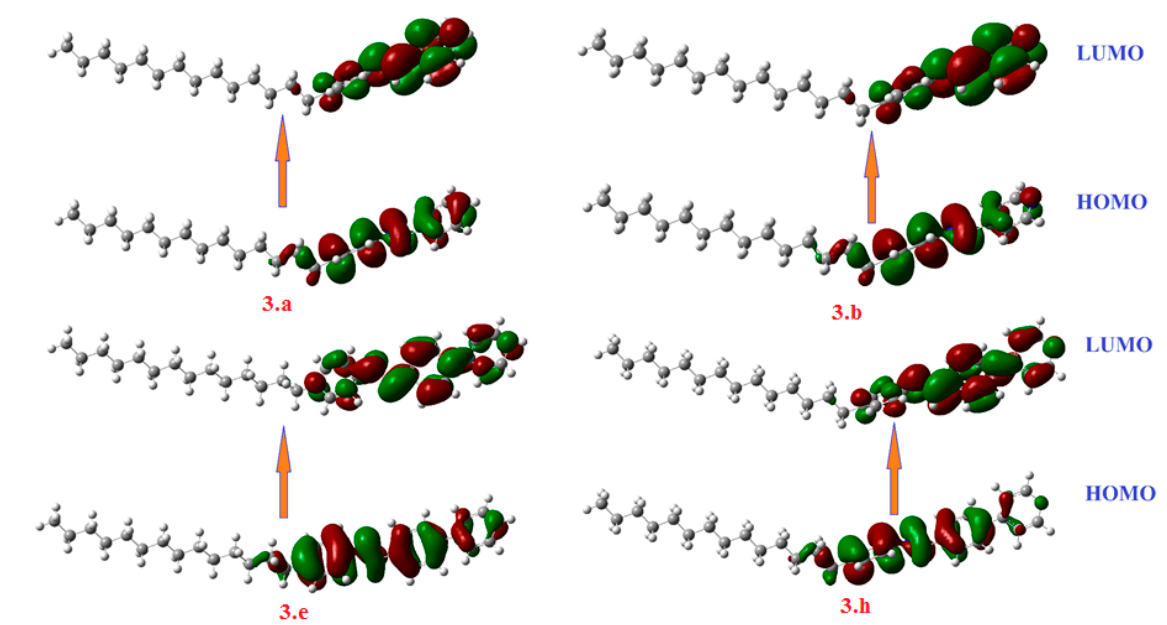
Figure 5. The calculated plots for the prepared compounds 3.a , 3.b , 3.e and h of the frontier molecular orbitals.